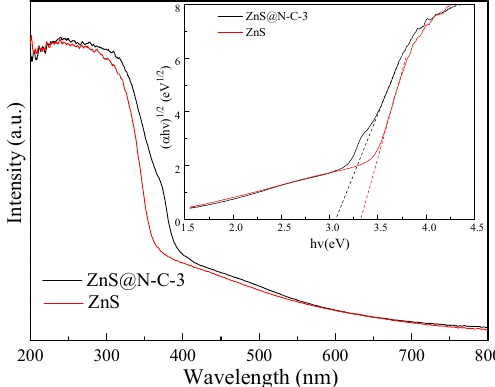
Figure 7. UV–vis diffuse reflectance spectroscopy (DRS) spectra and band gap analysis plot of ZnS and ZnS@N-C-3.